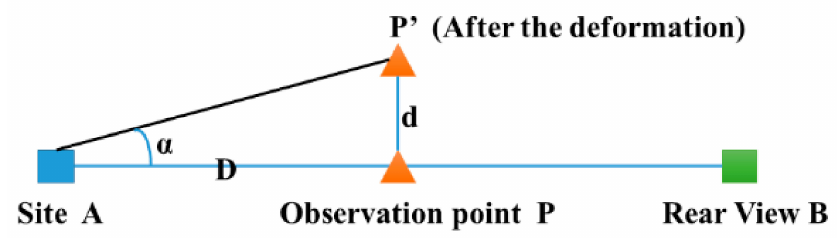
Figure 2. Schematic diagram of the measurement setup.